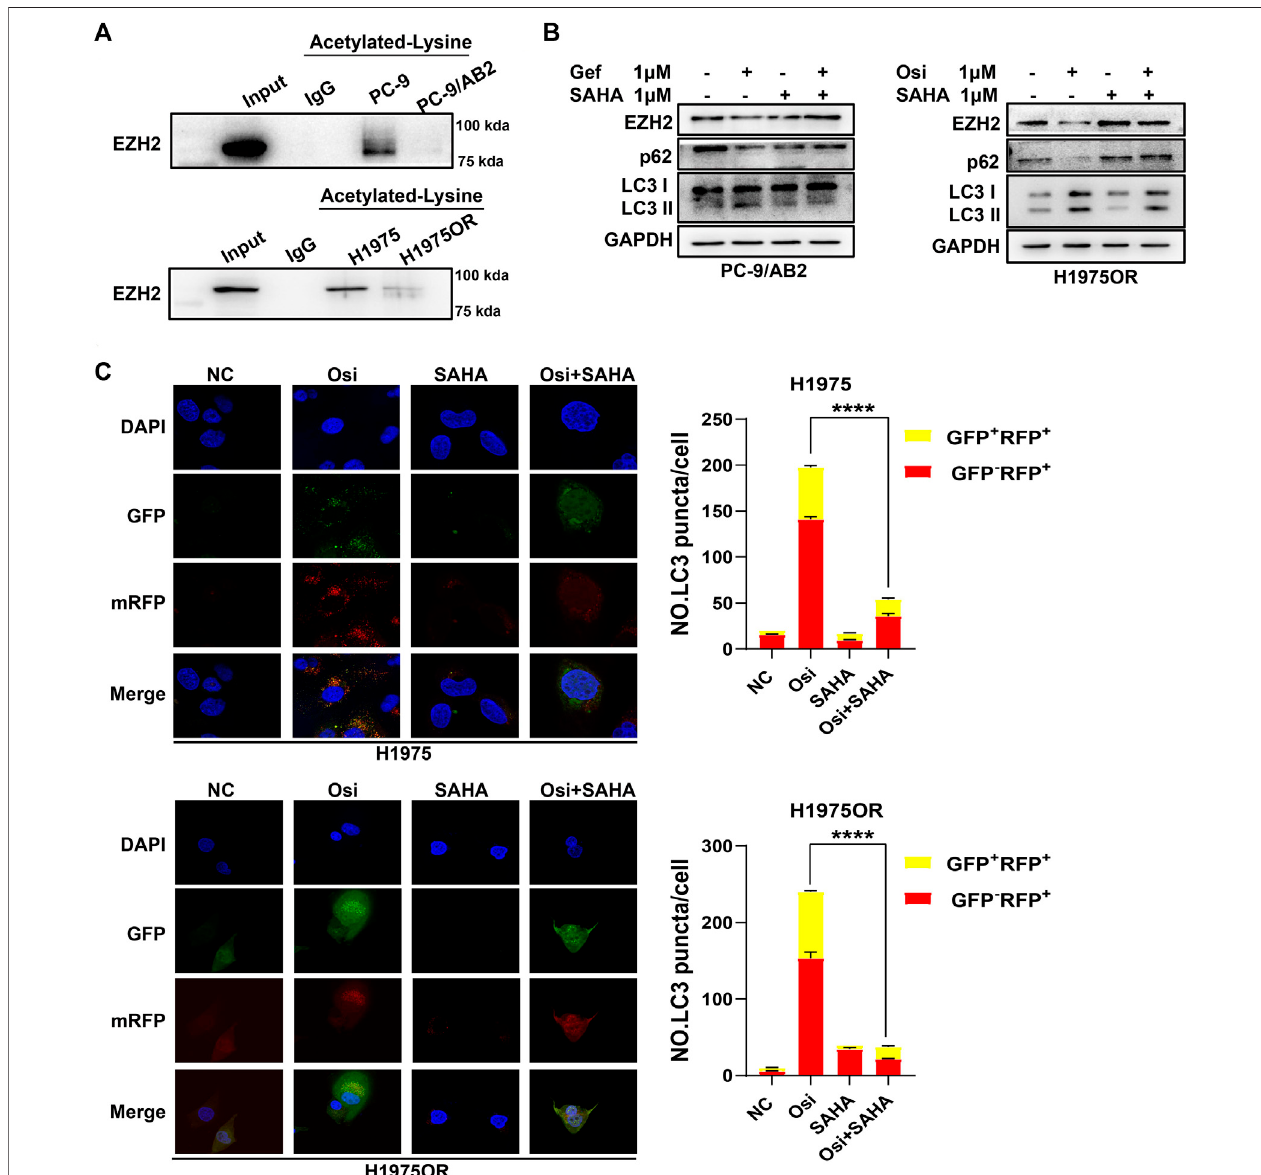
FIGURE3| SAHA reversedtheeffects ofincreasedautophagyanddecreasedEZH2expression inducedbyEGFR-TKIs. (A) Theacetylationlevelofdrug-resistant cellswaslowerthanthecorrespondingsensitivecells.Aftertreatmentofcellswith1 μ MSAHAfor48 h,celllysateswereimmunoprecipitatedwithrabbitanti-acetylated- lysineantibodyornormalrabbitIgGantibody,followedbyanti-EZH2antibodyforimmunoblotting. (B) WesternblottingshowedthatSAHAreversedtheeffectsofEGFR- TKIsonEZH2proteinexpressionandautophagyindrug-resistantcells. (C) FluorescenceassayshowingrepresentativeimagesofcellstransfectedwithGFP-RFP- LC3 double-labeled adenovirus. SAHA reversed the increased autophagic fl ux induced by EGFR-TKIs. **** p < 0.0001.